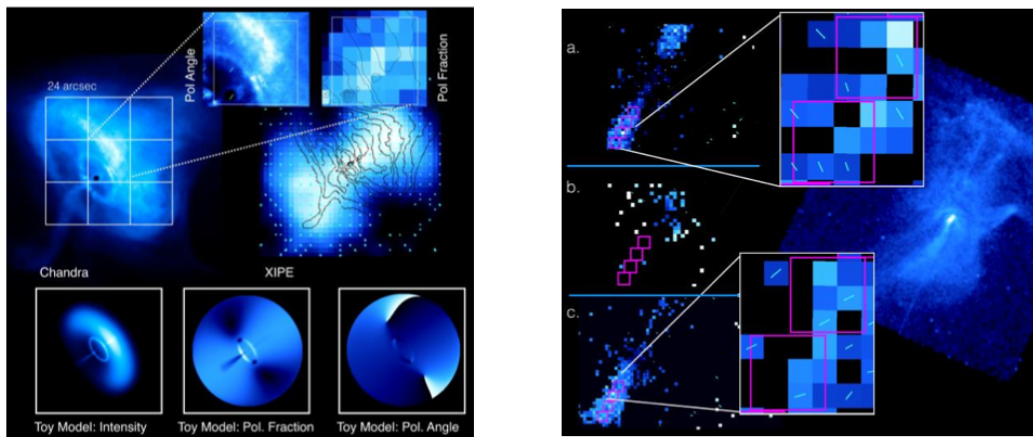
Figure 2. Left panel: Simulation of the Crab Nebula as seen by XIPE in 0.2 Msec. The toy model mimics the Chandra image for a given polarization angle and fraction. Right panel: Simulations of the PWN MSH 15-52 as seen by XIPE in 2 Msec. The images a, b, and c show the expected intensity map when three different polarization models are applied to the Chandra intensity map: ( a ) a fully ordered radial B-field, ( b ) a fully disordered B-field, and ( c ) a fully ordered perpendicular B-field. From the XIPE Yellow Book, see also